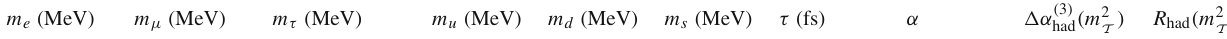
) ratio in e + e − collisions, both evaluated at the T mass and R had ( m 2 T scale, used in this work [17]. The quoted value of (cid:10)α ( 3 ) ( m 2 ) , puted using alphaQED19 [18,19] had T